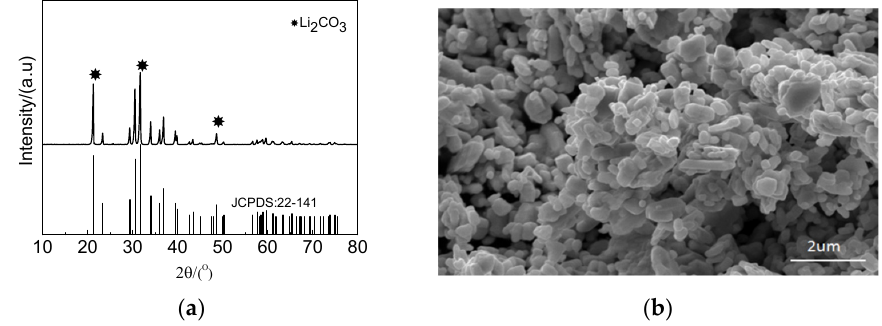
Figure 16. Characteristics of Li precipitate: ( a ) XRD pattern and ( b ) SEM image.